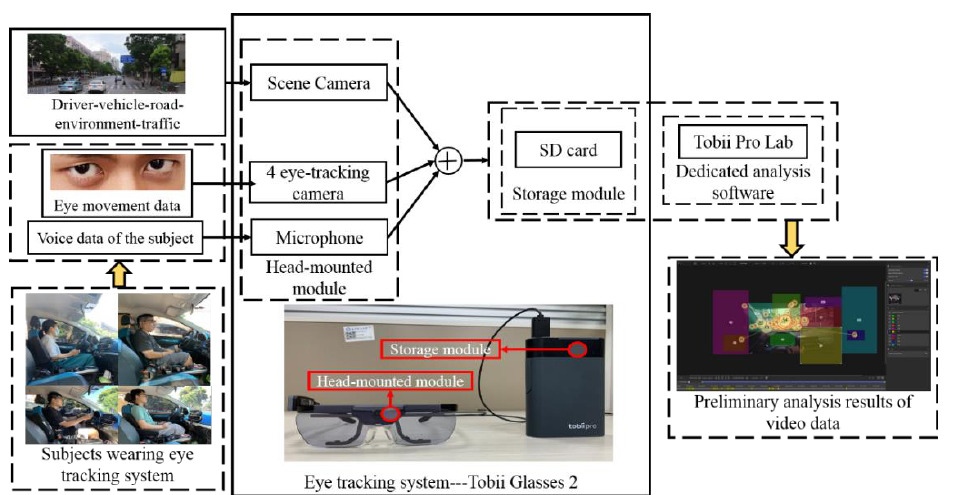
Figure 1. Introduction to the principle of the Tobii Pro Glasses and preprocessing of video data.